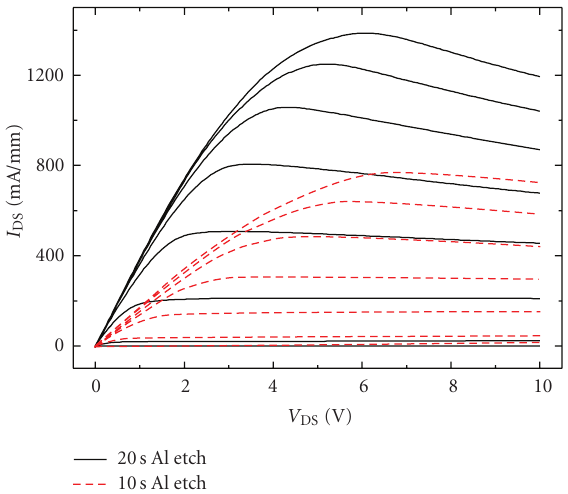
Figure 8: I DS against V DS characteristics of fabricated 3 μ m × 100 μ m gate AlN/GaN MOS-HEMT devices with di ff erent etching times using the simplified gate wrap-around method. The devices are biased from V GS = +3V to − 4 V with step size of 1V.